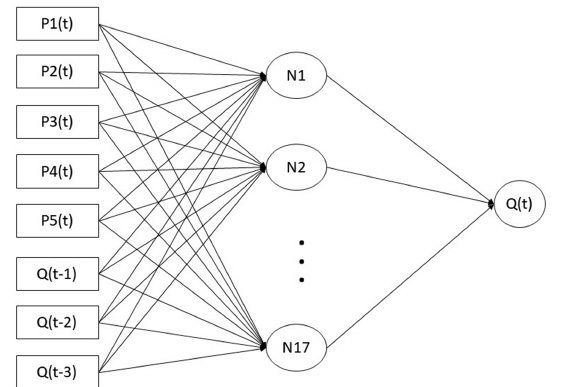
Figure 4. BP model flowchart. Note: P 1( t ), P 2( t ), P 3( t ), P 4( t